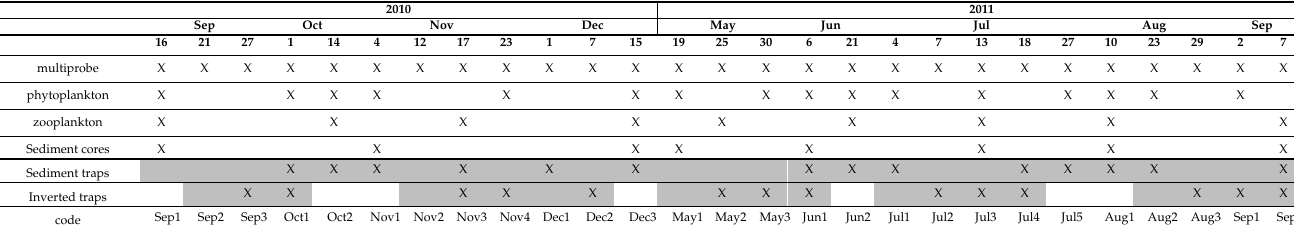
Table 1. Timetable of the sampling activities. T1 (2010) and T2 (2011). x: punctuated sampling; grey color: duration of collection activity of the sediment traps (direct and